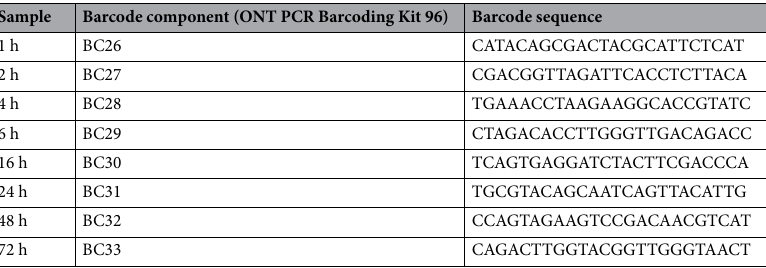
Table 4. Summary table of barcodes used for labeling the samples of different time points after infection.